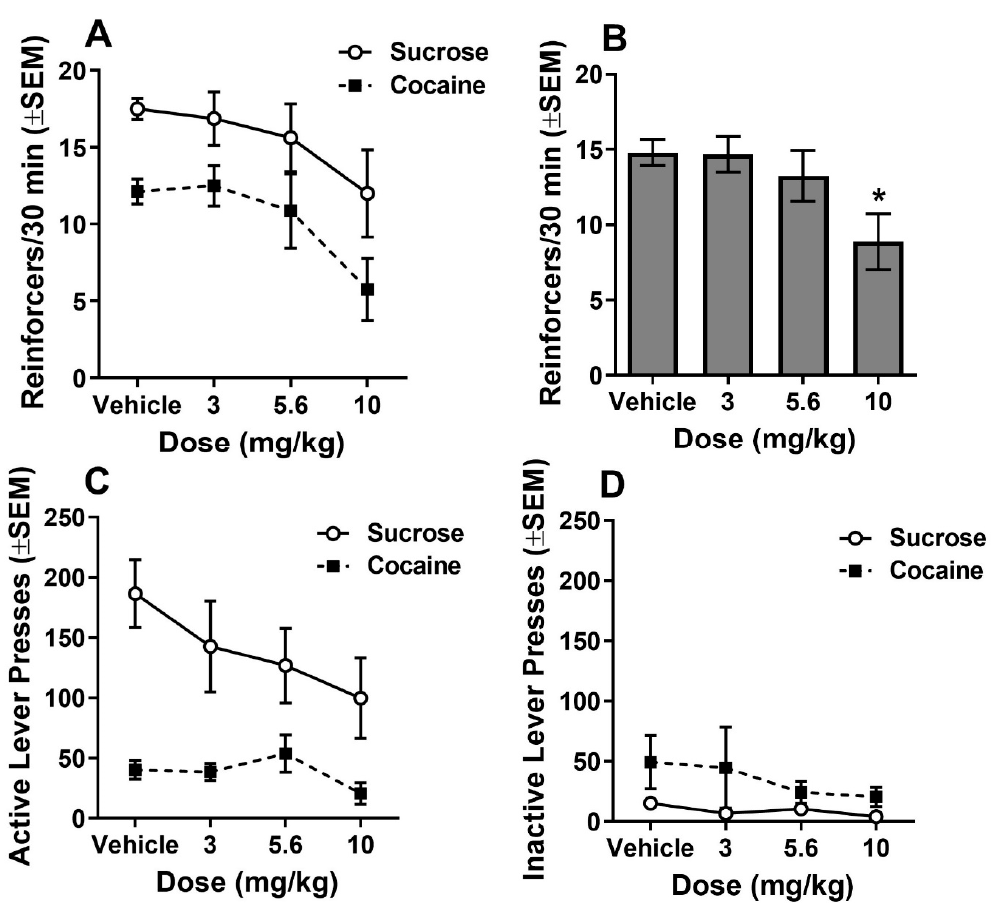
Figure 4. Multiple schedule of sucrose and cocaine reinforcement. Animals ( n = 8) were each tested on each of four doses of MC-25-41 (Vehicle, 3.0, 5.6, and 10 mg/kg) on a multiple VI60 s schedule in which 15-min schedule components alternated between sucrose (45 mg pellet) and cocaine (0.75 mg/kg, IV) availability for 1 hr. Shown are the individual reinforcers earned ( A ), reinforcers earned collapsed across reinforcer type ( B ), active lever presses ( C ), and inactive lever presses ( D ). Reinforcer and response rates were higher under the sucrose components compared to the cocaine components (main effect of reinforcer). Data points are the mean ± standard error of the mean (SEM). * indicates a significant difference from vehicle.